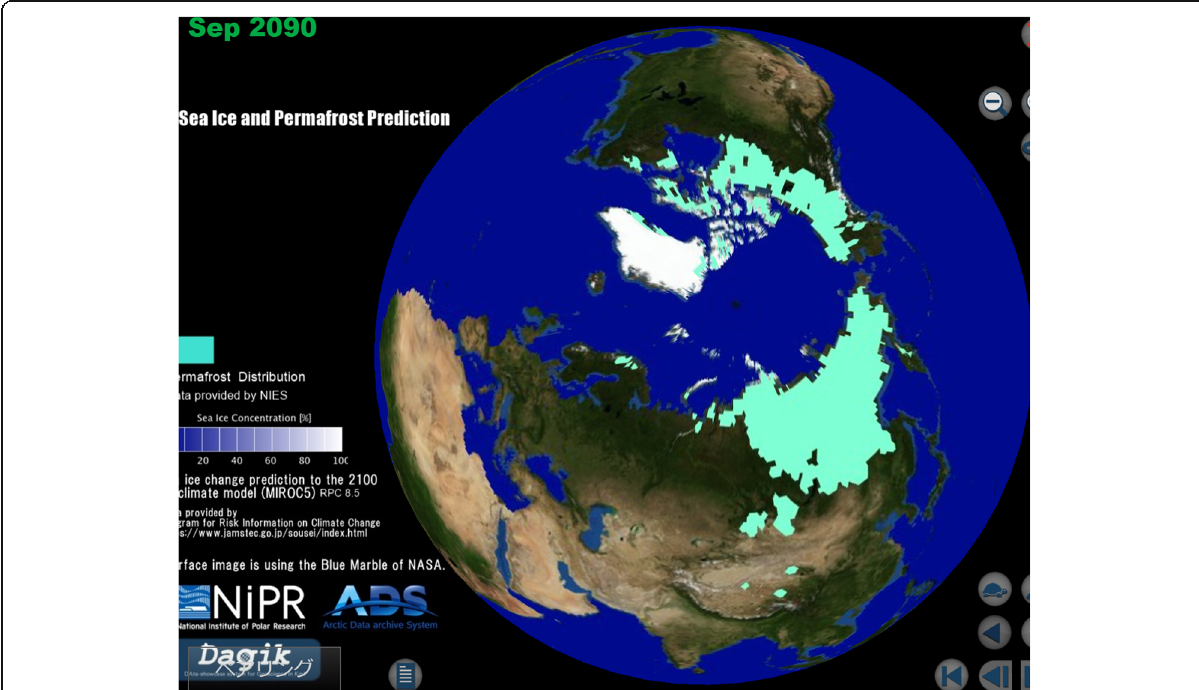
Fig. 12 Snapshot of an animation of future projections of the permafrost area based on data from simulations using the improved scheme with the MIROC atmospheric forcing under the RCP8.5 scenario. The animation was generated based on a tool developed by the Dagik Earth project (https://www.dagik.net/). The full animation is available at